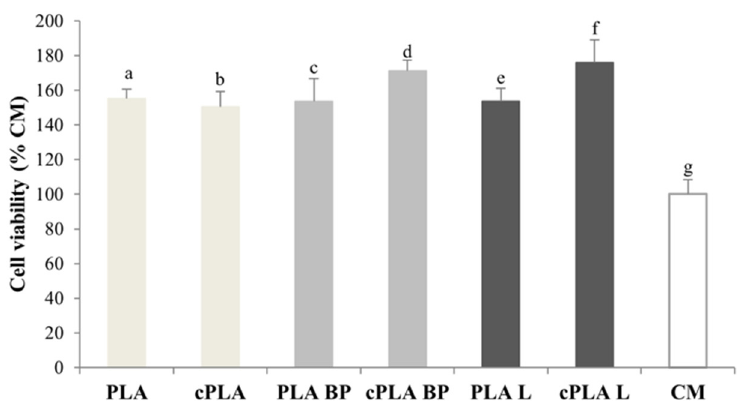
Figure 8. Cell viability (% CM) after incubation for 3 days with PLA, PLA-BP, and PLA-L fibrous membranes, coated and uncoated (mean values ± s.d.; n = 5). CM was considered as control. ANOVA one-way ( p < 0.05), Multiple Range Test: a vs. g; b vs. g; c vs. g; d vs. e, f, g; e vs. g; f vs. g.